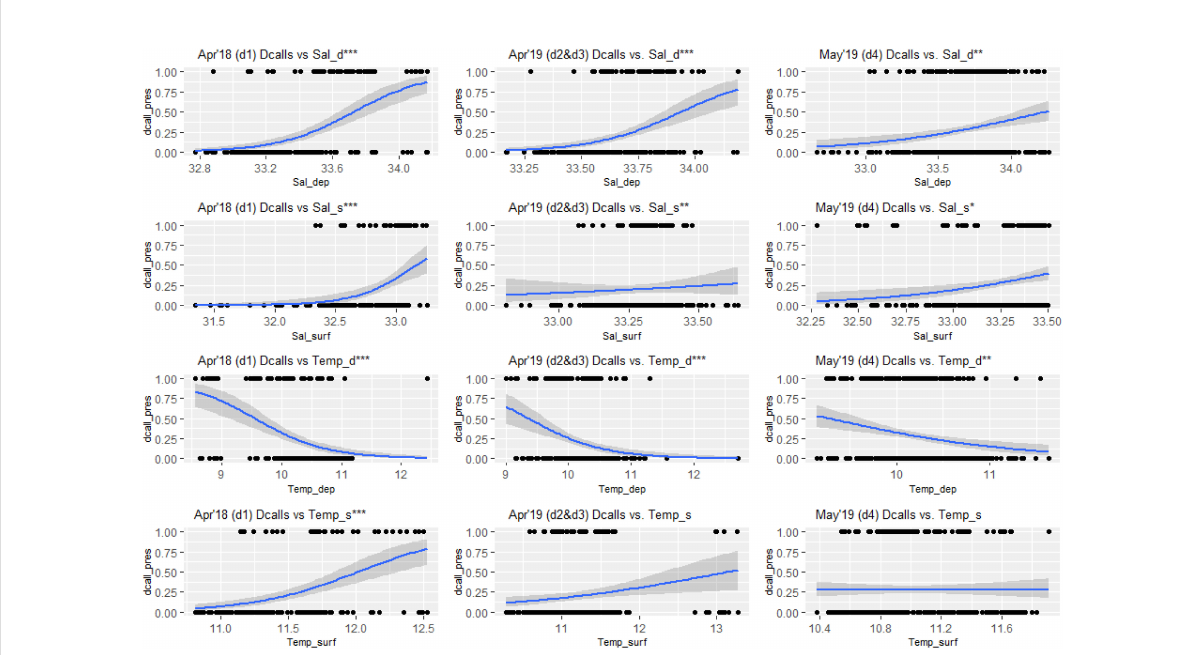
FIGURE 5 Generalized Linear Model response curves for blue whale D-call presence and deep layer salinity (SalD), surface layer salinity (SalS), deep layer temperature (TempD) and surface layer temperature (TempS). Salinity in psu and temperature in °C. Study periods: April 2019 (deployment 1), April 2019 (deployments 2 and 3), May 2019 (deployment 4). Bonferroni adjusted signi fi cance codes: *0.00416 > p > 0.00083; **0.00083 > p > 0.000083; *** p <